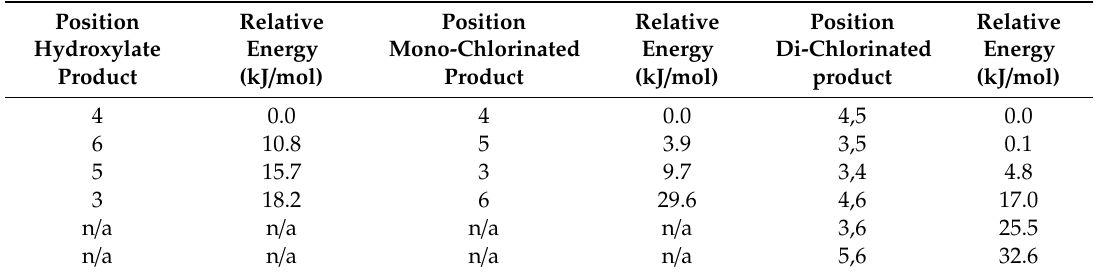
Table 1. Relative energy of hydroxylated and chlorinated